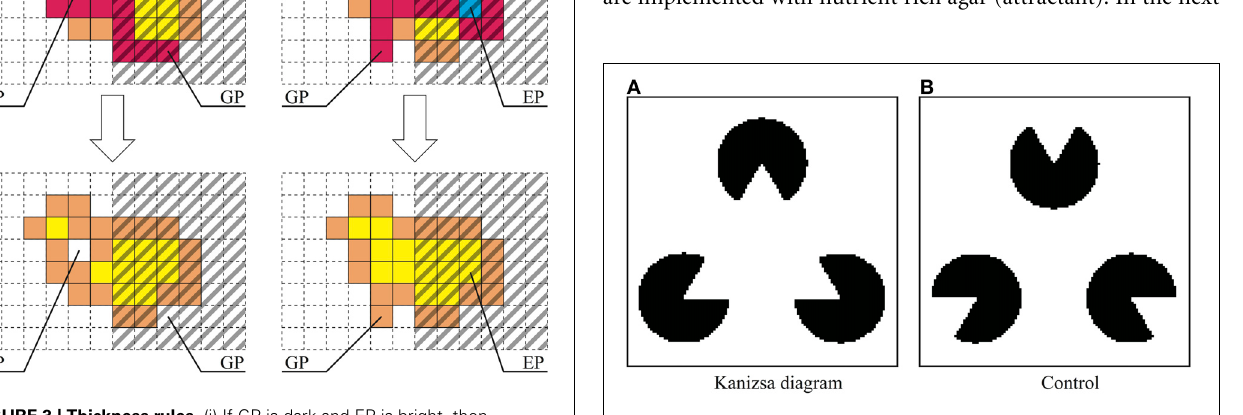
FIGURE 4 | Stimulus figures are given as geometrical patterns of brightness (black or white). (A) Kanizsa diagram and (B) control